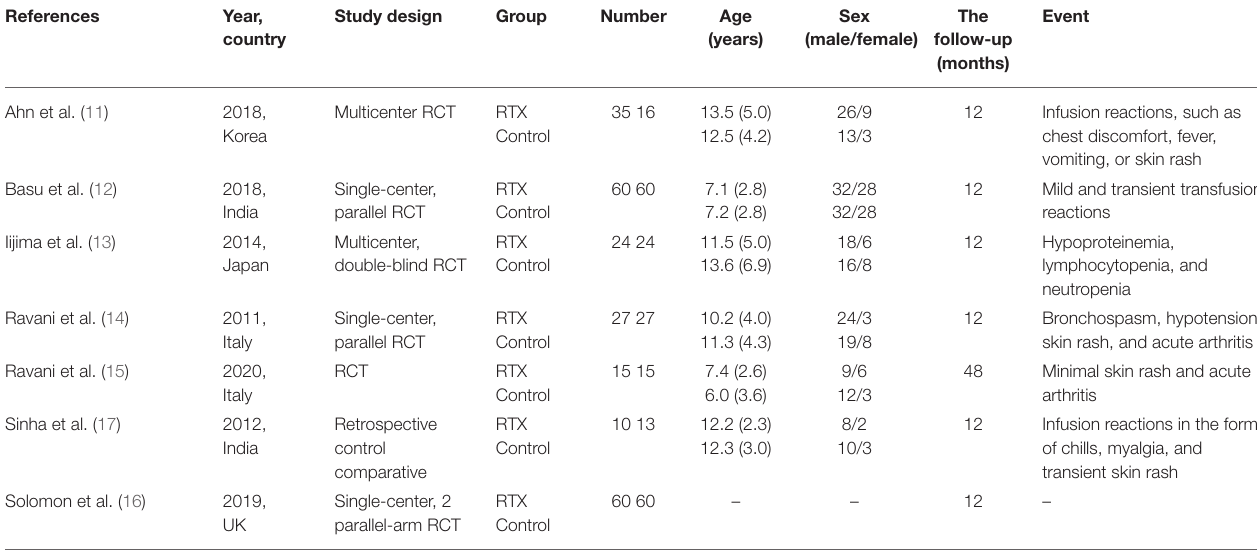
TABLE 1 | Characteristics of studies included.